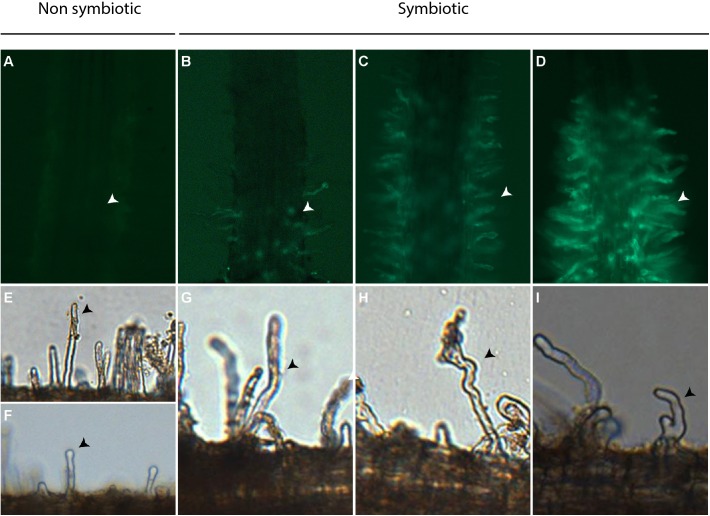
Bioassays used to quantify the activation of ProCgNIN and root hair deformation in C. glauca.
(A–D) Representative images showing levels of GFP fluorescence in root hairs of transgenic ProCgNIN:GFP C. glauca plants used for the CgNINA bioassay. Arrowheads indicate root hairs. (A) no signal, level 0; (B) weak signal, level 1; (C) medium signal, level 2; (D) strong signal, level 3. (E–I) representative images showing levels of root hair deformation in C. glauca used in the CgRHDF bioassay. (E) no deformation, level 0a; (F) tip swelling, level 0b; (G) one change in growth direction, level 1; (H) more than one change in growth direction but no bifurcation;, level 2; (I) one or more bifurcations, level 3. Arrowheads indicate deformed root hairs.